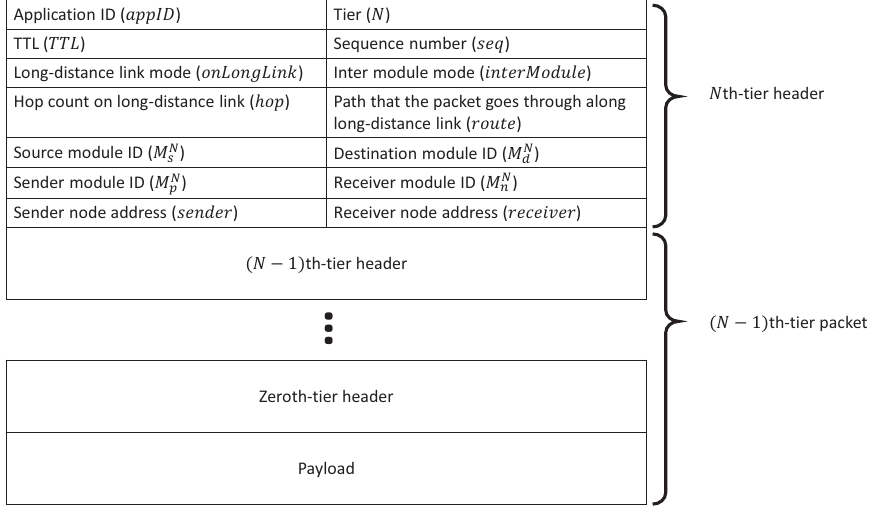
Figure A1. Format of the N -th-tier header prepended to ( N − 1 ) -th-tier packets.